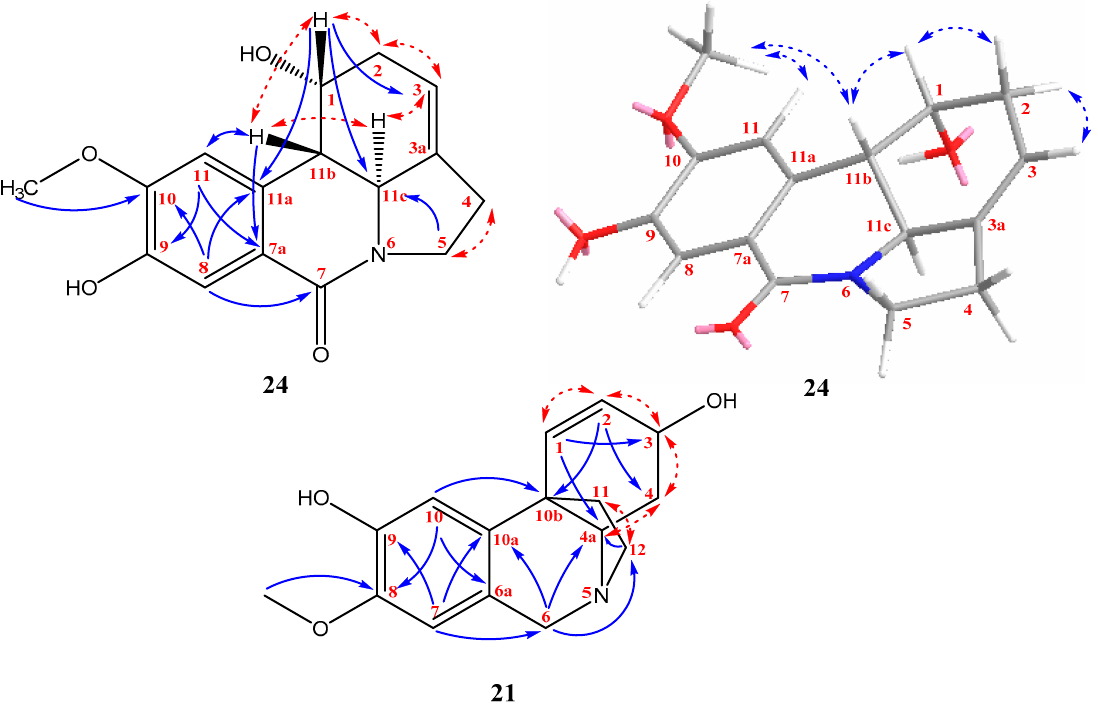
Figure 2. The constitution of 21 ; the constitution of 24 and its relative configuration. The key gCOSY (red dashed arrows), gHMBCAD (blue arrows), and NOESY (blue dashed arrows) correlations are marked.